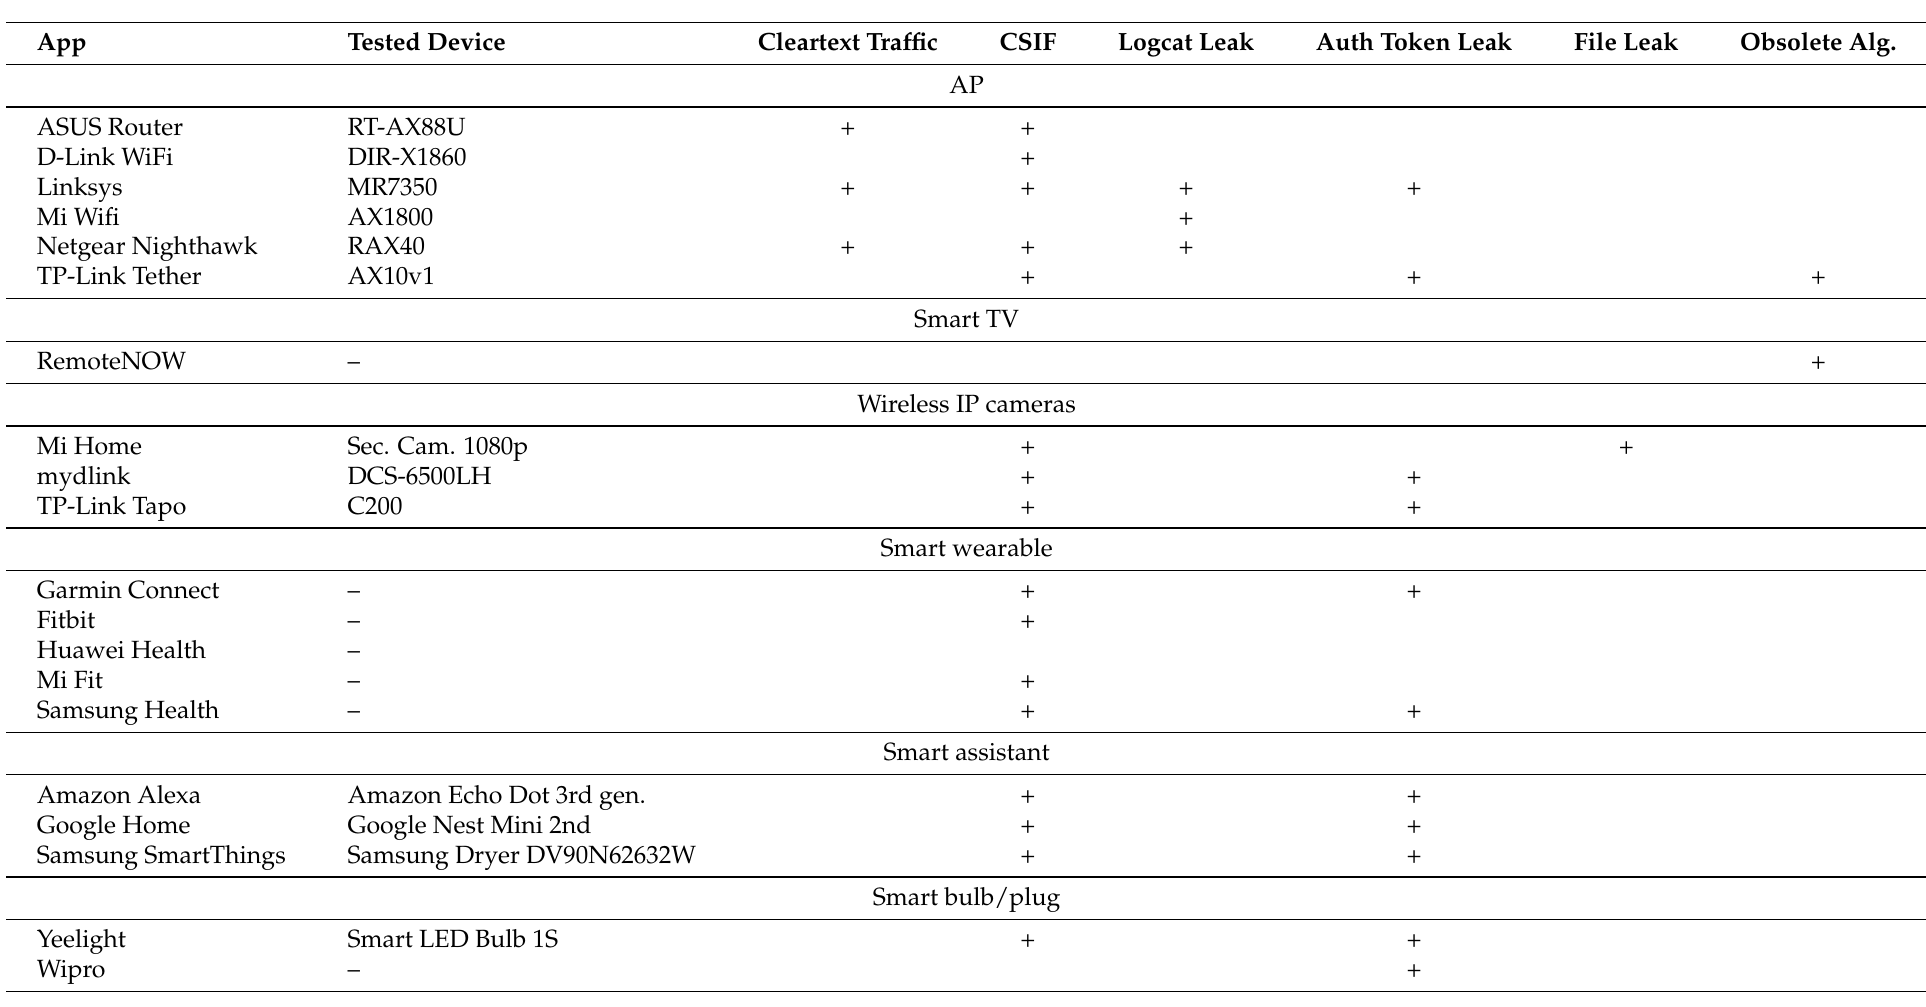
Table 6. Overview of issues identified through dynamic analysis. CSIF denotes the cleartext sensitive information, say, Wi-Fi passphrases kept in app’s